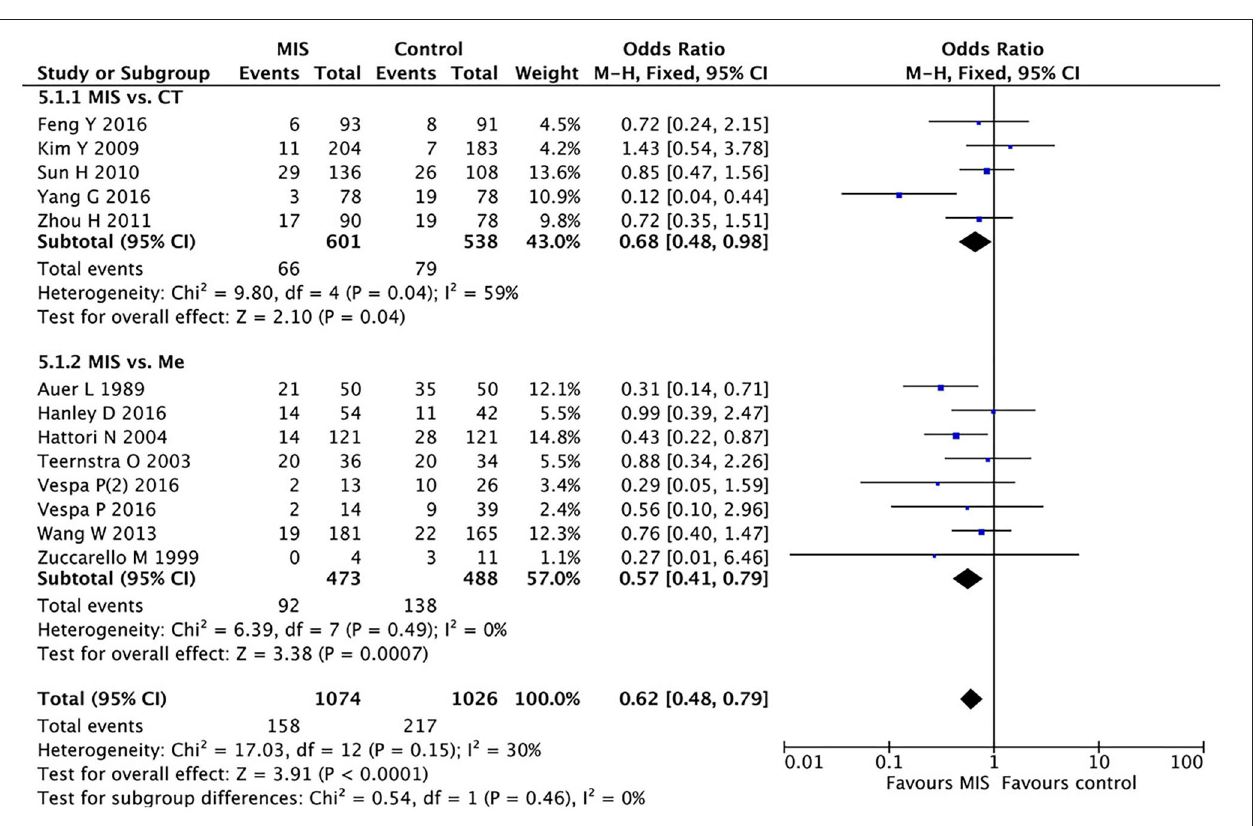
FIGURE 5 | A forest plot of the subgroup analysis of the minimally invasive surgery (MIS) and craniotomy and MIS and medication groups for overall